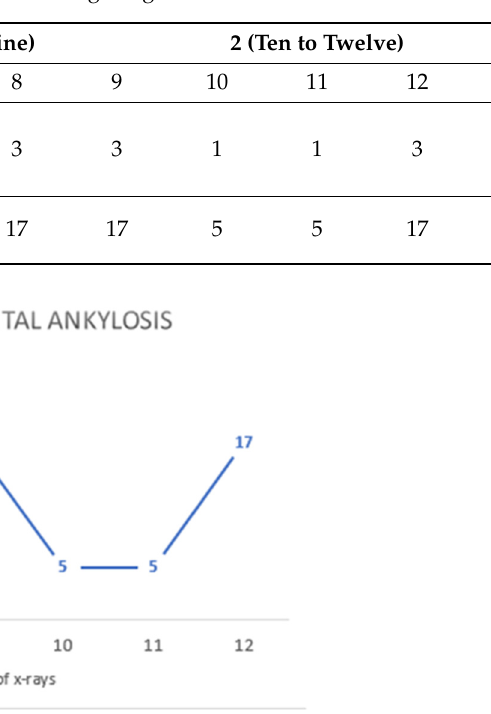
Table 2. Distribution of dental ankylosis according to age.